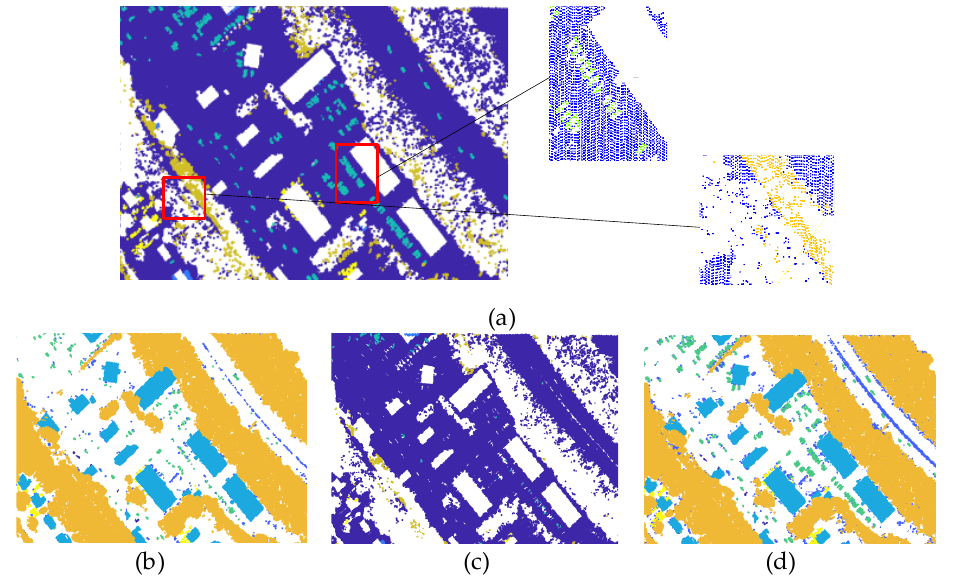
Figure 2. Results contrast between Cloth Simulation Filter (CSF) and Algorithm 1: ( a ) Ground points obtained from CSF algorithm. Details of misjudgment are also shown; ( b ) off-ground points obtained from CSF algorithm. Much information of small size objects is lost; ( c ) ground points obtained from Algorithm 1. Error samples between ground and classes are obviously refined; ( d ) off-ground points obtained from Algorithm 1. Enough information of small size objects, which directly affects the results, can be provided by higher-order potential.